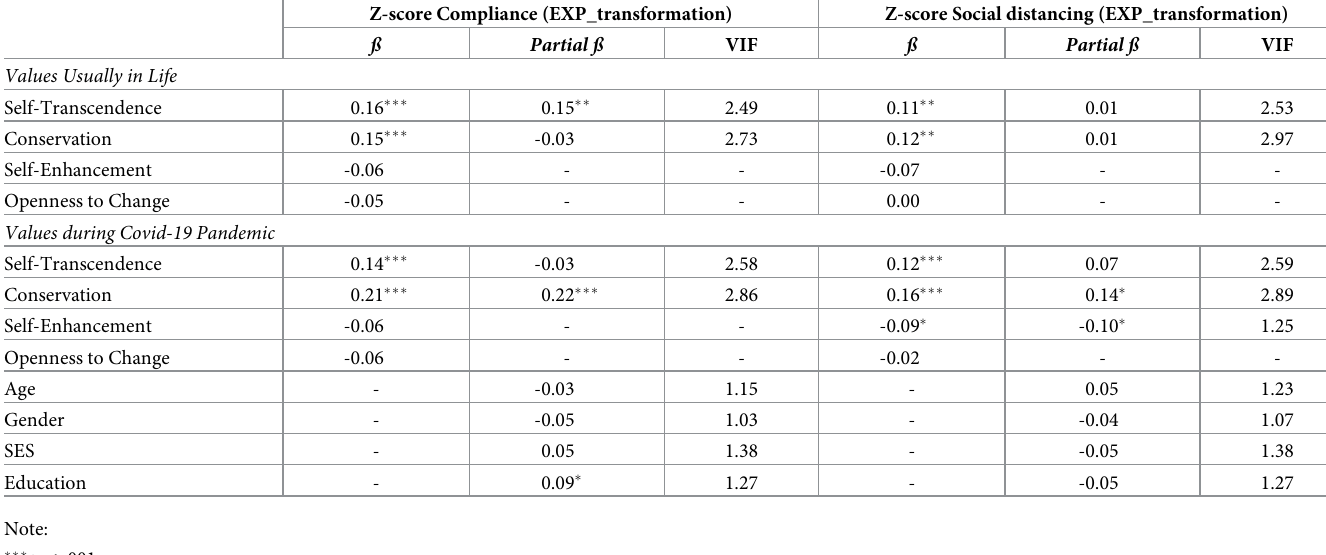
Table 3. Beta coefficients and partial coefficients (standardized) between Schwart’s values, compliance with movement restrictions and social distancing.